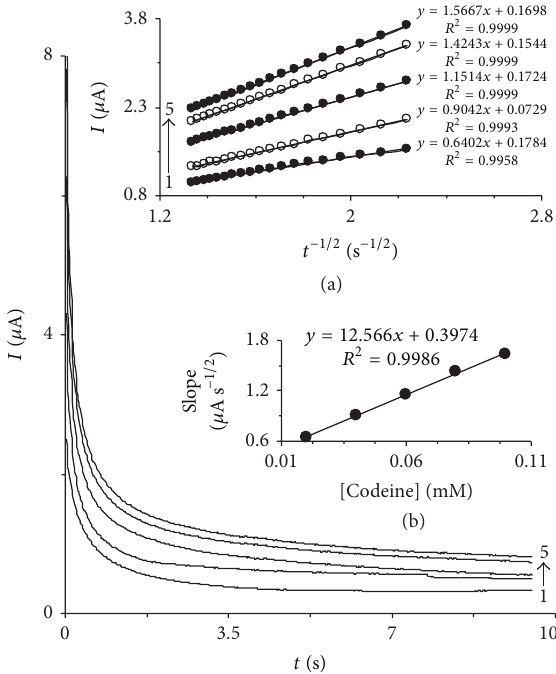
Figure 4: Chronoamperometric current responses at HTP- MWCNT-CPE surface in a 0.15 M phosphate buffer solution (pH 7.0), at a step potential of 235 mV, for different concentrations of codeine. The numbers of 1–5 correspond to 0.02, 0.04, 0.06, 0.08, and 0.1 mM of codeine. Insets: (a) plots of 𝐼 versus 𝑡 −1/2 obtained from chronoamperograms and (b) plot of the slopes of the straight lines against the codeine